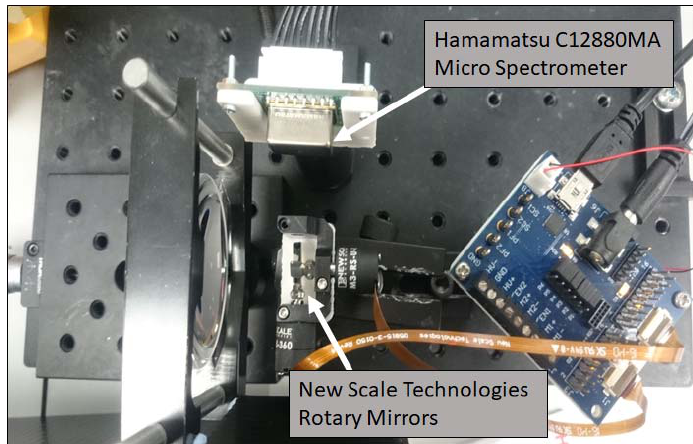
Sensors 2020 , 20 , 3293 Figure 1. Components of the hyperspectral set ‐ up. Figure 1. Components of the hyperspectral set-up.